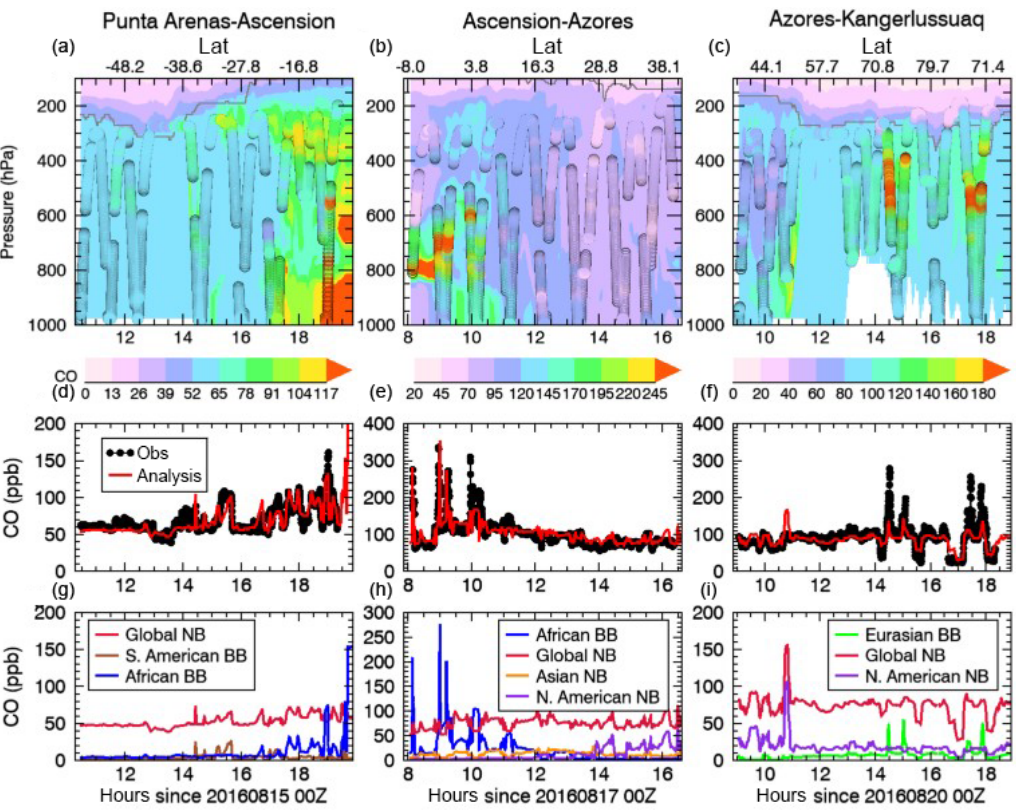
Figure 2. As in Fig. 1 but for the Atlantic flights: (a, d, g) Punta Arenas to Ascension Island, (b, e, h) Ascension Island to the Azores, and (c, f, i) Azores to